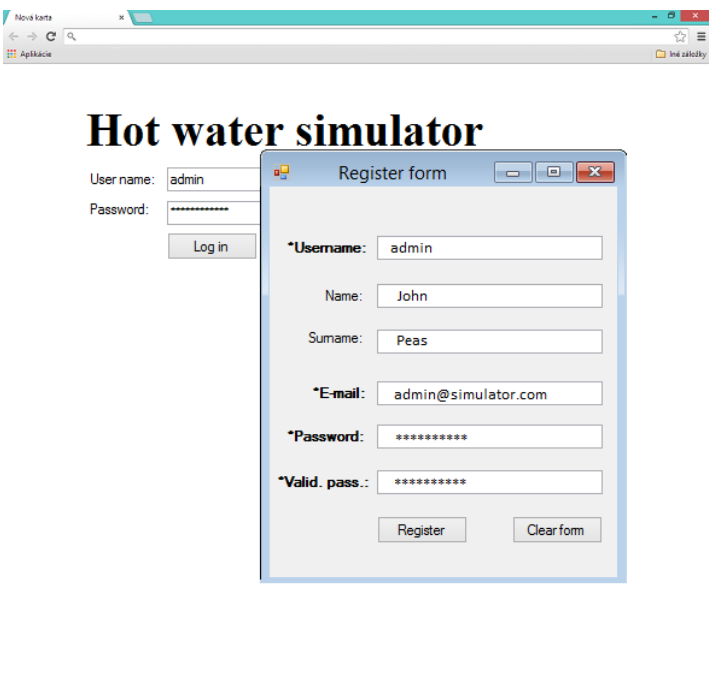
Figure 4. Web interface for the designed